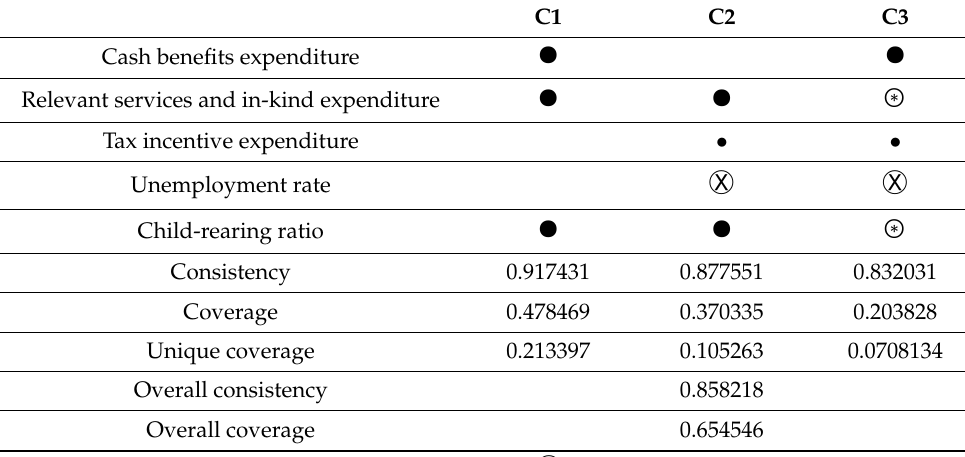
Table 10. Grouping of family welfare policies to boost fertility.